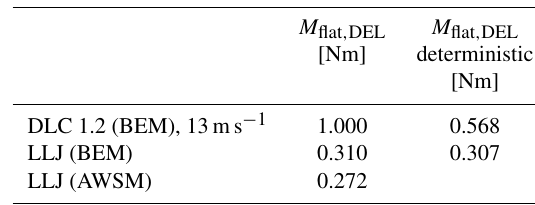
Table 3. Comparison of equivalent blade root flatwise moment for extreme low-level jet (relative to the DEL of DLC